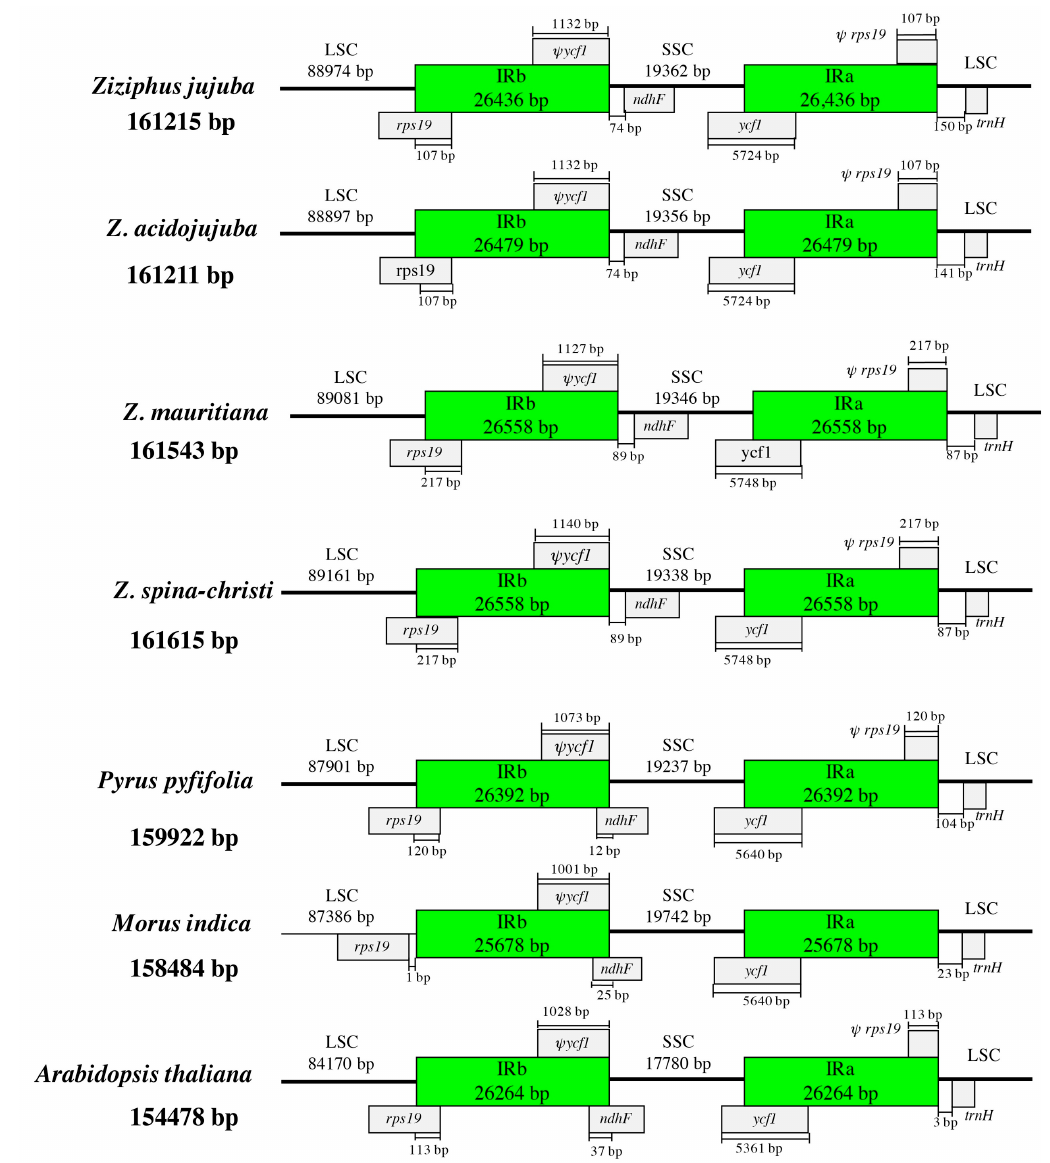
Figure 2. Comparisons of LSC, SSC, and IR border regions among the four Ziziphus chloroplast genomes.